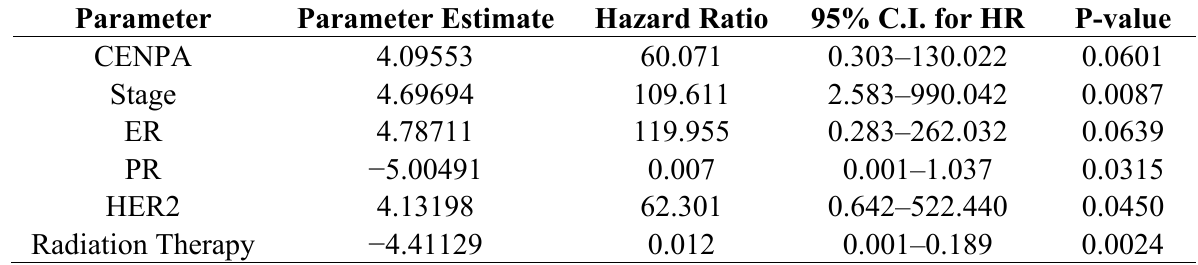
Table 4. Cox proportional model to predict disease free survival. Multivariate analysis showing hazard ratios (HR), Confidence intervals (C.I.) and P values in the breast cancer patient